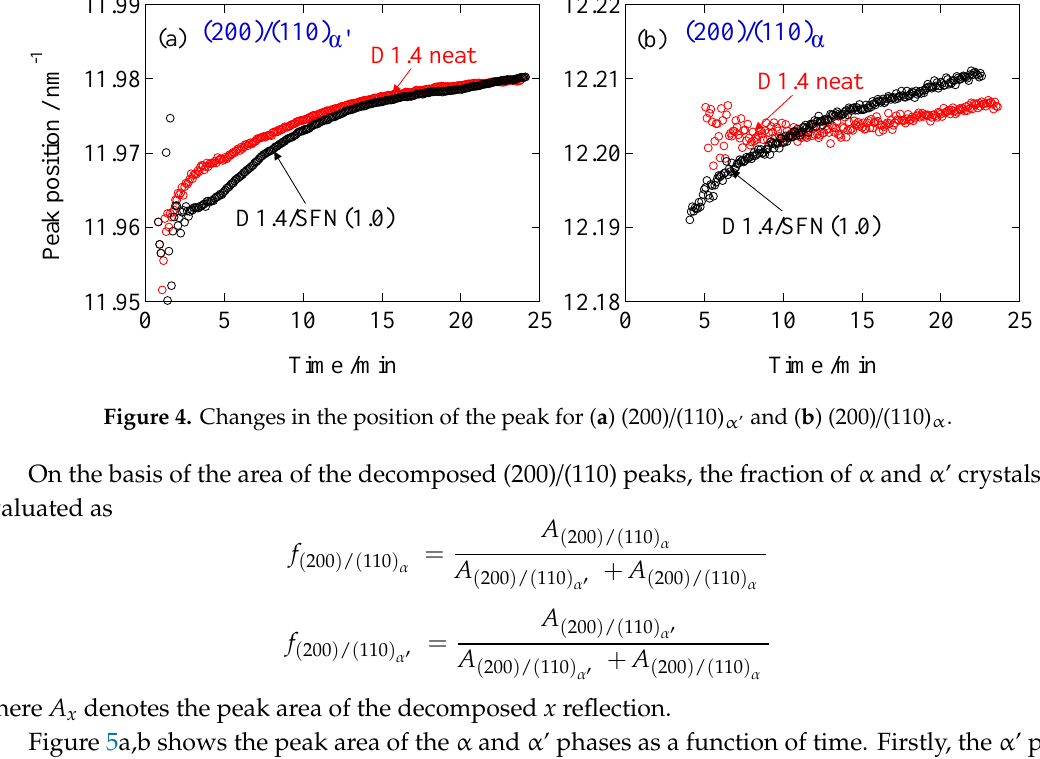
Figure 5. Plots of the peak area as a function of time for ( a ) the decomposed (200)/(110) ( b ) the decomposed (200)/(110)